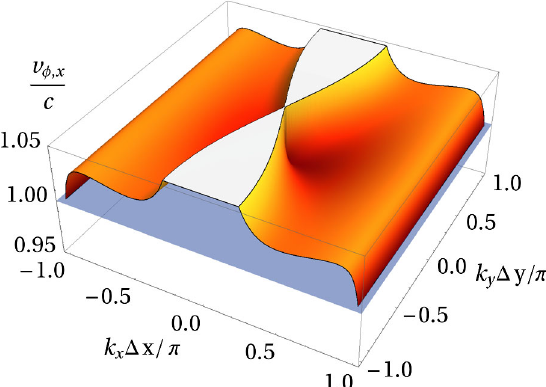
FIG. 7. Numerical phase velocity along x [ v from Eq. (8)] as a function of k modes propagating in the x - y plane ( k plane corresponds to v between these two surfaces. Although not shown on this figure, there is no intersection either for the other modes ( k